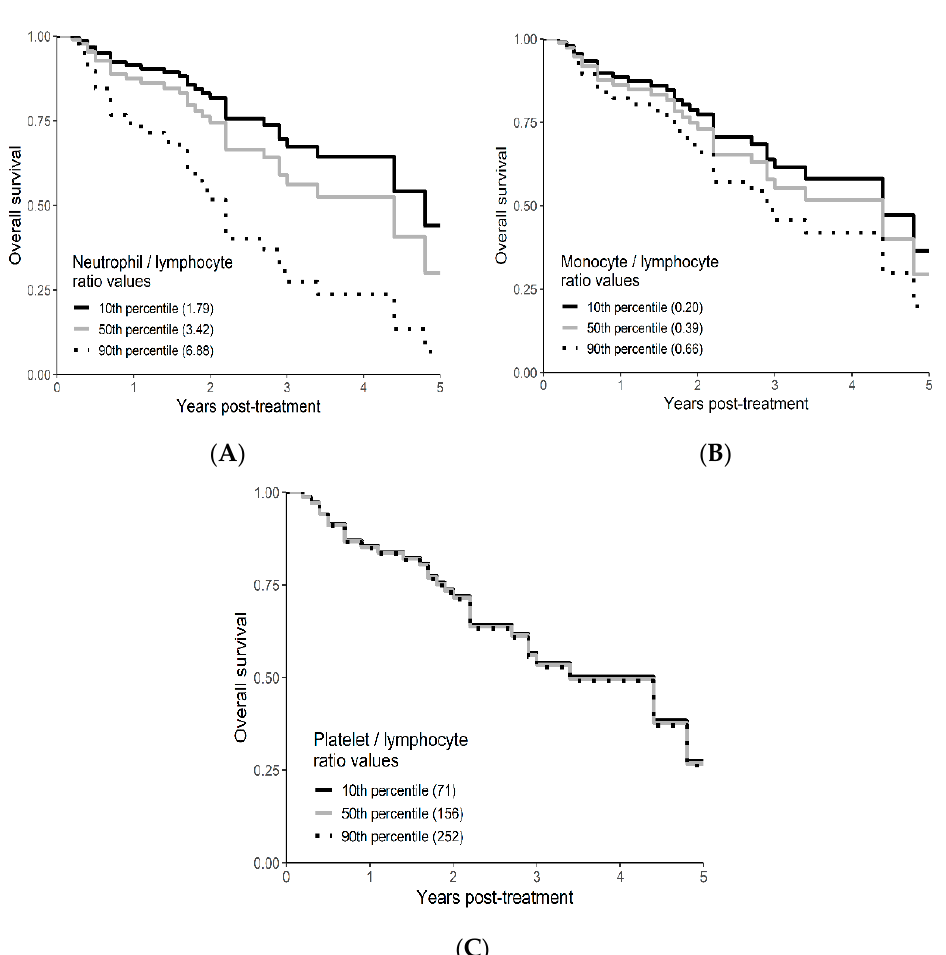
Figure 3. Kaplan–Meier curves for OS by NLR ( A ), MLR ( B ), and PLR ( C ) using predicted values at the 10th, 50th, and 90th percentile of predictors.